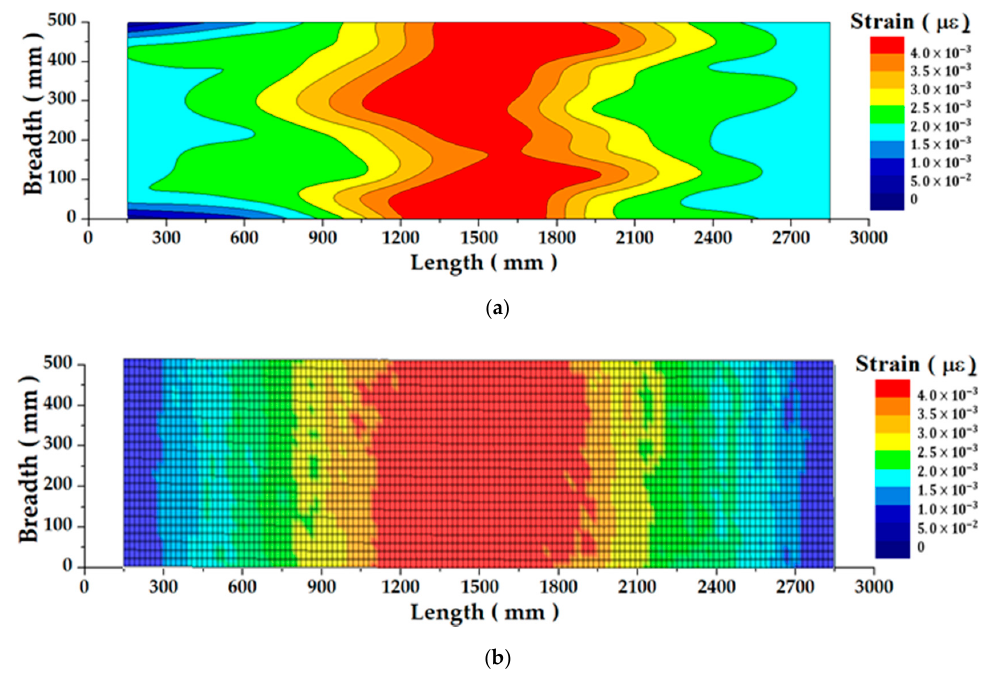
Figure 9. Comparison of CFRP strain distributions using BOTDR sensor and analysis (A-100). ( a ) BOTDR, ( b ) FEM.